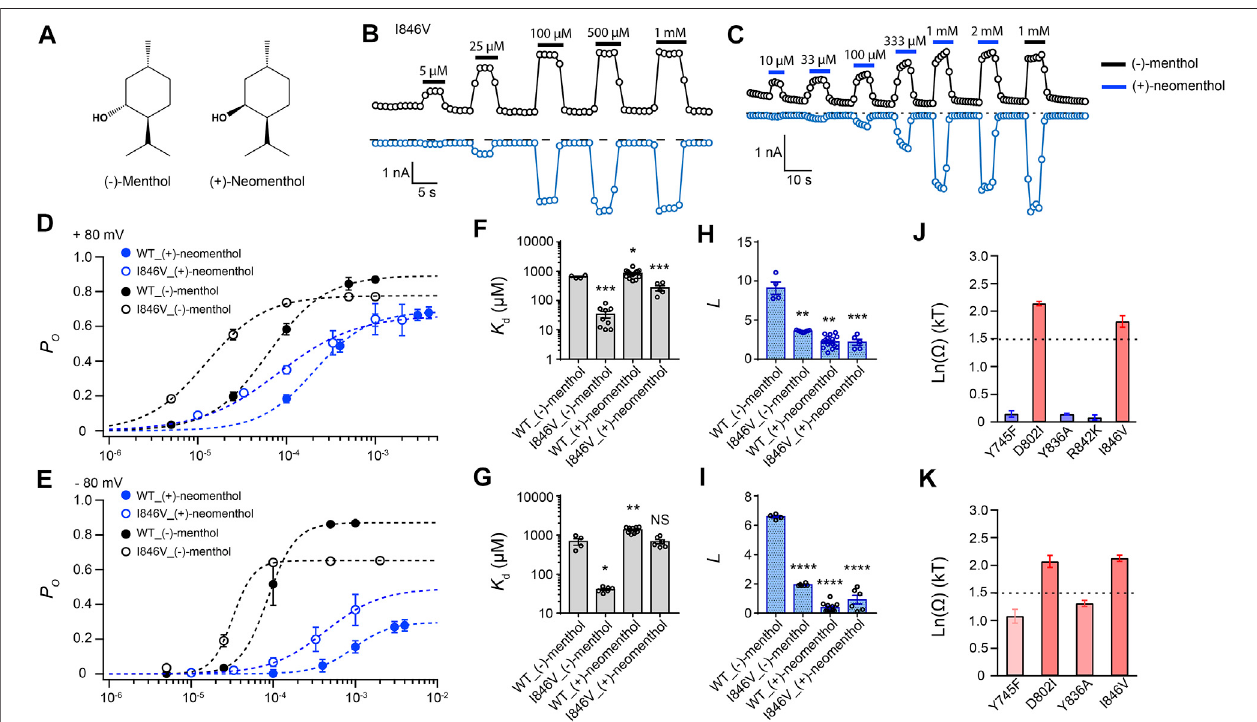
FIGURE 3 | Differential interactions between mouse TRPM8 and ( − )-menthol or (+)-neomenthol revealed by TMCA. (A) Comparison of chemical structures of ( − )-mentholand (+)-neomenthol isshown. (B) Representative whole-cell recordings ofthe I846V mutant channel activated by( − )-mentholin aconcentration-dependent manner. (C) Representative whole-cell recordings of the I846V mutant channel activated by (+)-neomenthol in a concentration-dependent manner. (D) Concentration – responsecurves ofwild typeand mutant such asI846Vwith either( − )-menthol or(+)-neomentholactivationweremeasured from whole-cell patch- clamprecordingsat+80 mV( n =5 – 9). (F) and (H) ForwildtypeandI846Vchannel, K d and L at+80 mVvalueswerecalculatedfromtheconcentration – responsecurves in (D) (two-sided t -test, * p < 0.05; ** p < 0.01; *** p < 0.001; **** p < 0.0001; NS, not statistically signi fi cant). (J) Summary of coupling energy measurements at +80 mV. Couplingenergywascalculatedfromthe K d values.Mutantsshowingacouplingenergylargerthan1.5kT(dashedline)werecoloredinred.Thosewithlessenergywere colored in different shades of blue. At least four independent trials were performed for each chemical at each concentration. (E) Concentration – response curves of wild typeandmutantsuchasI846Vwitheither( − )-mentholor(+)-neomentholactivationweremeasuredfromwhole-cellpatch-clamprecordingsat − 80 mV( n =5 – 9). (G) and (I) For wild type and I846V channel, K d and L values at -80 mV were calculated from the concentration – response curves in (E) (two-sided t -test, * p < 0.05; ** p < 0.01; *** p < 0.001; **** p < 0.0001; NS, not statistically signi fi cant). (K) Summary of coupling energy measurements at − 80 mV. Coupling energy was calculated from the K d values. Mutants showing a coupling energy larger than 1.5kT (dashed line) were colored in red. Those with less energy were colored in different shades of blue. At least four independent trials were performed for each chemical at each